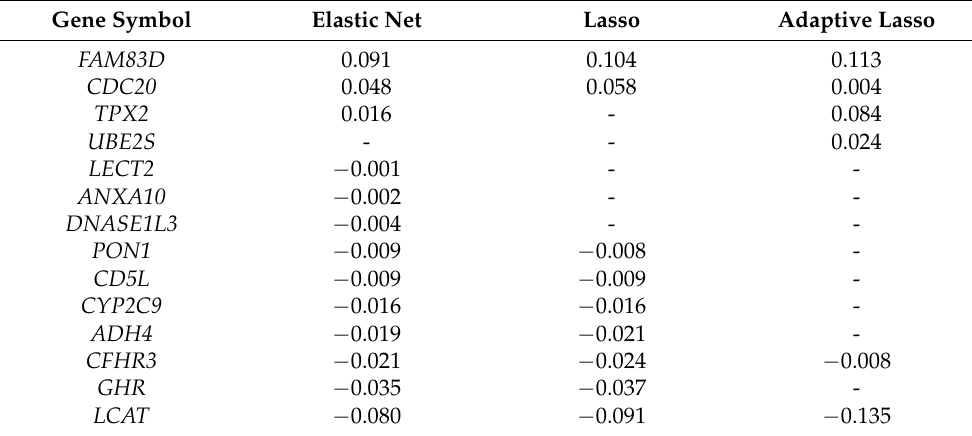
Table 1. The regression coefficients of survival-related genes identified by three penalized Cox methods. Gene Symbol Elastic Net Lasso Adaptive Lasso FAM83D